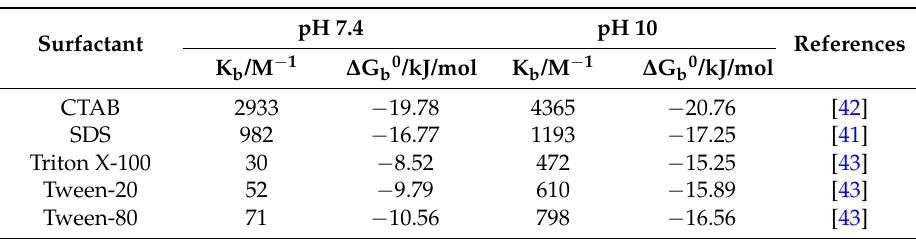
Table 2. Binding constant (K b ) and the Gibbs free energy of binding ( ∆ G b0 ) for the interaction of mitoxantrone with different surfactant